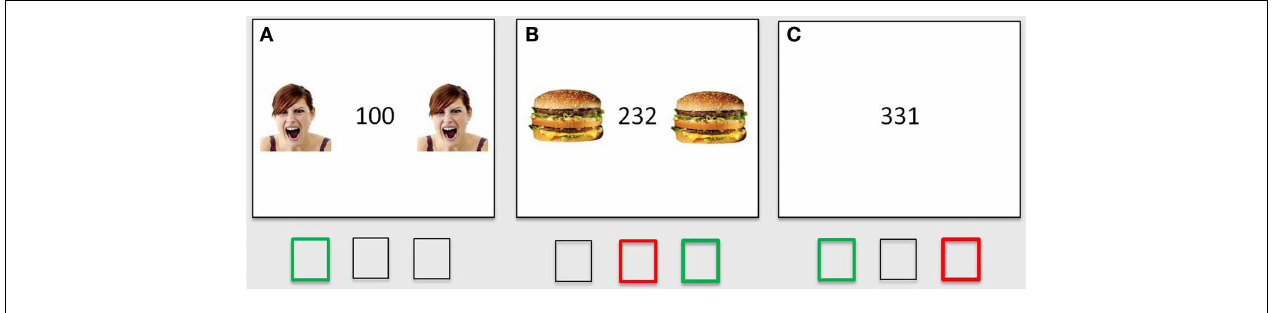
emotionally neutral stimuli; C ).The correct responses are shown in green; common incorrect responses on incongruent trials (i.e., indicating the position instead of the value of the oddball number) are shown in